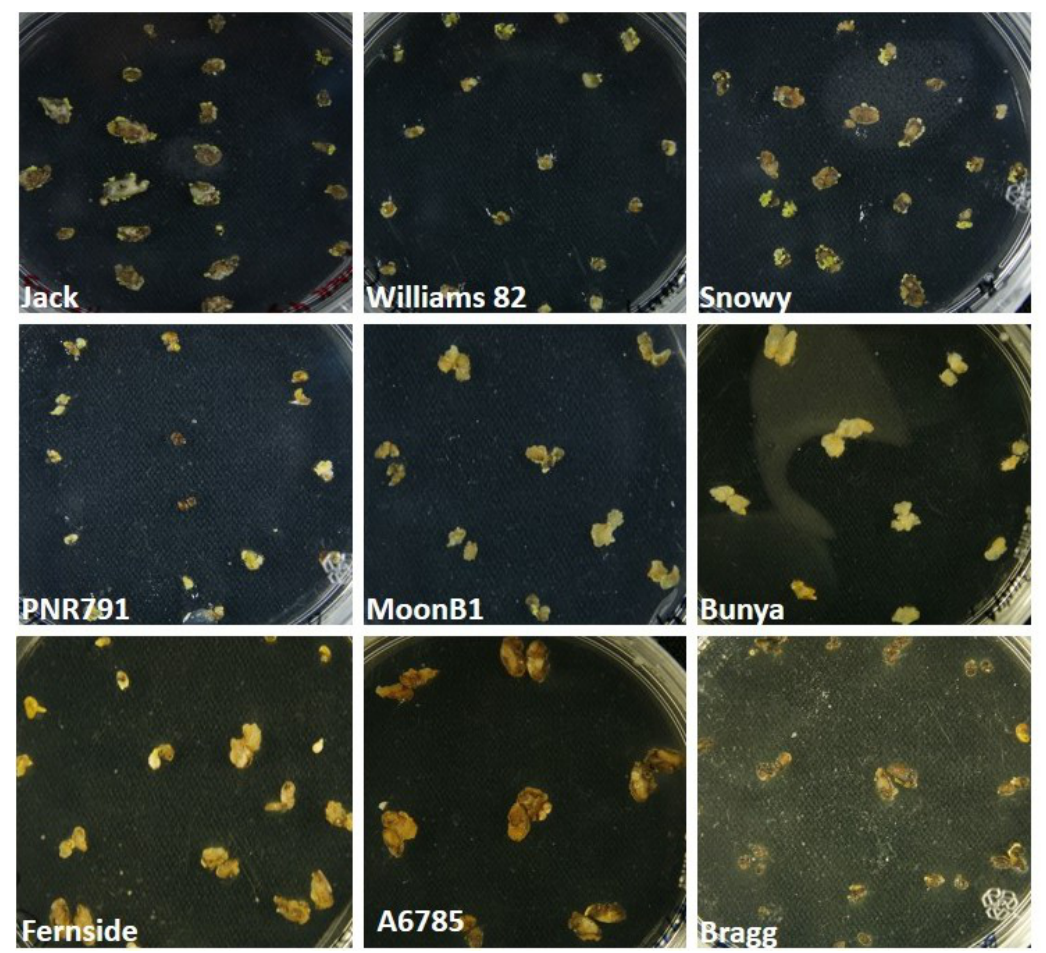
Figure 2. Explants from different soybean cultivars during somatic embryos induction.